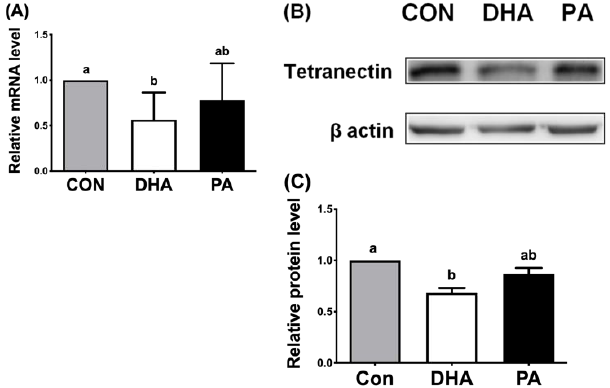
Figure 4. Effects of fatty acids on TN expression in porcine mature adipocytes in vitro. ( A ) Gene expression of tetranectin (TN/ CLEC3B ), normalized to β -actin expression, in the mature adipocytes, differentiated from adipose stem cells/pre-adipocytes. Treatments were BSA solutions with the vehicle control (ethanol; CON), 100 µ M of docosahexaenoic acids (DHA) or 100 µ M of saturated palmitic acids (PA) for 24 h and then extracted and determined by qPCR. ( B ) Western blot of TN and β -actin protein expression. ( C ) Quantification of western blots for TN protein expression among fatty acid treatments in mature adipocytes. Data were expressed as mean ± SD ( n = 6–8 for each group) and normalized to β -actin expression in the same sample. Data were analyzed by ANOVA. Different superscript letters (a, b) indicate significant difference ( p ≤ 0.05) determined by Tukey’s multiple comparison test.